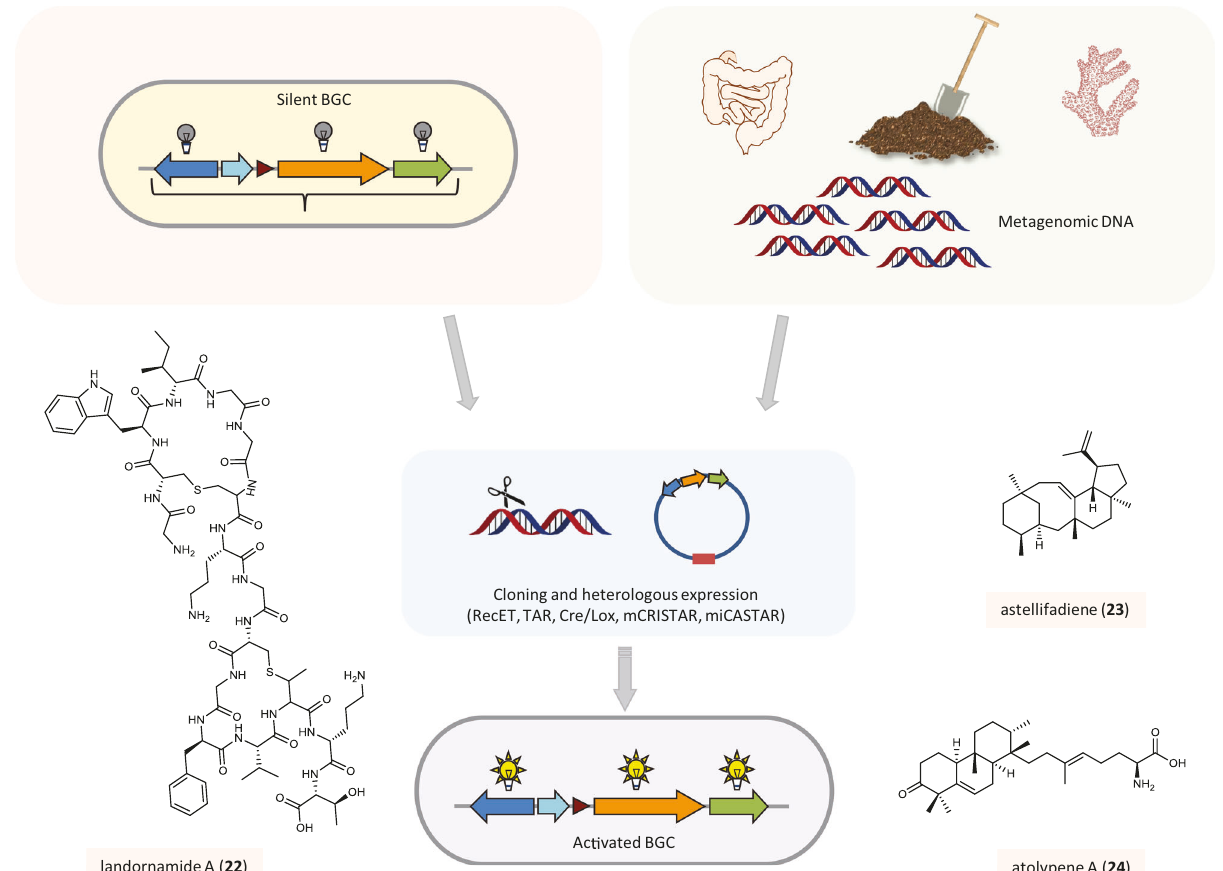
Fig. 3 Accessing cryptic biosynthetic genes in heterologous hosts. Strategies for the activation of silent biosynthetic gene clusters in heterologous hosts and examples of natural products discovered through these methods. (BGC biosynthetic gene cluster). The color code of the boxes around the compound names and icons indicates the strategy that was applied for the discovery of the respective compound: Activation of natural product biosynthesis through heterologous expression of biosynthetic genes that are downregulated in the native producer (light orange) or from metagenomic DNA